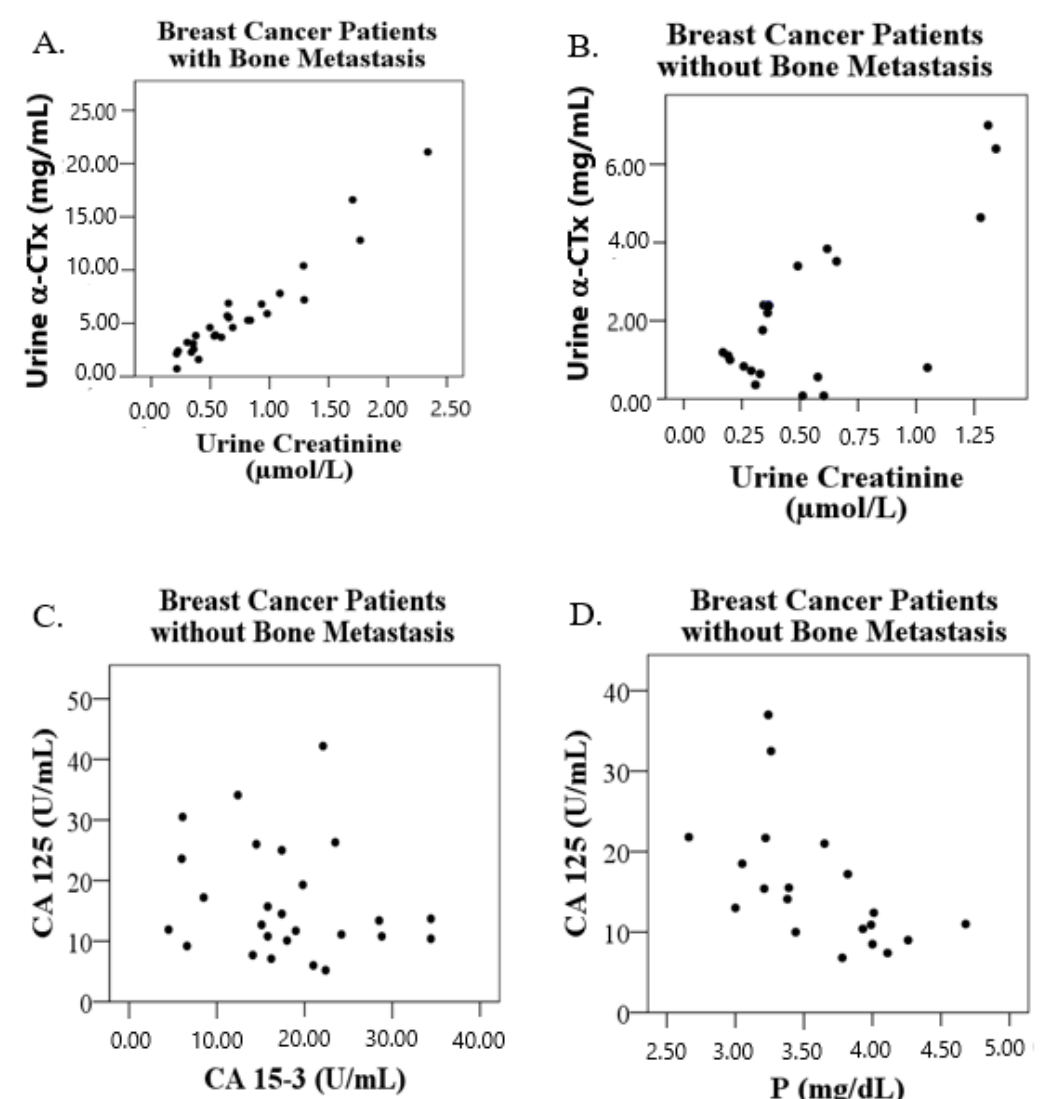
Figure 4. Correlation graphs of the bone metastasis status of patients with breast cancer. A. Correlation between urine α -CTx and urinary creatinine in breast cancer patients with bone metastases; B. Correlation between urine α -CTx and urinary creatinine in breast cancer patients without bone metastases; C. Correlation between CA-125 and CA 15-3 in breast cancer patients without bone metastases; D. Correlation between CA-125 and P in breast cancer patients without bone metastases. Table 3. Cut-off points, sensitivity, specificity, and AUC to distinguish breast cancer patients from control individuals.